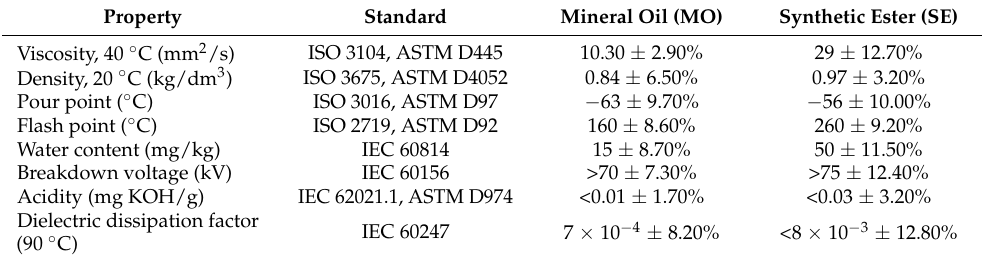
Table 3. Properties of commercial oils